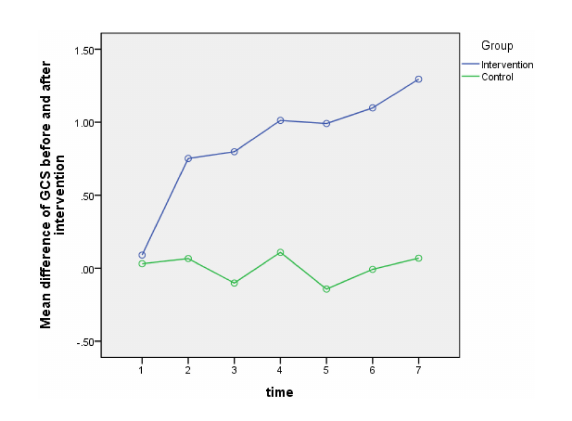
FIGURE2 The GCS score changes in the study groups in seven time